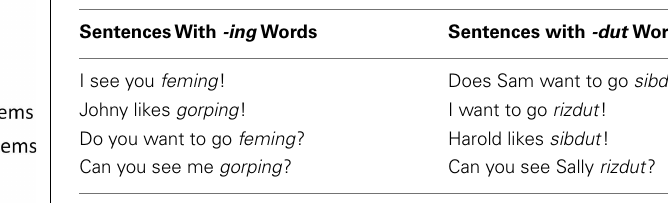
Table 6 | Familiarization sentences for subjects in groupA, in Experiment